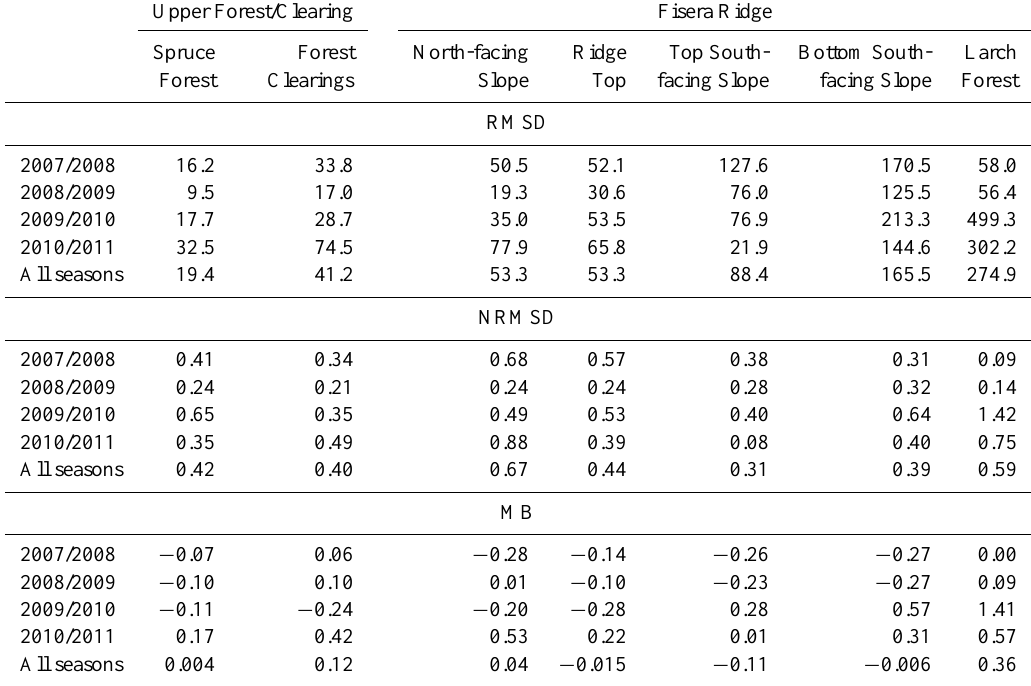
Table 3. Evaluation of simulated snow accumulations via the root mean square difference (RMSD, mm SWE), normalised RMSD (NRMSD), and model bias (MB) at Upper Forest/Clearing and Fisera Ridge sites, Marmot Creek Research Basin during seasons from 2007 to